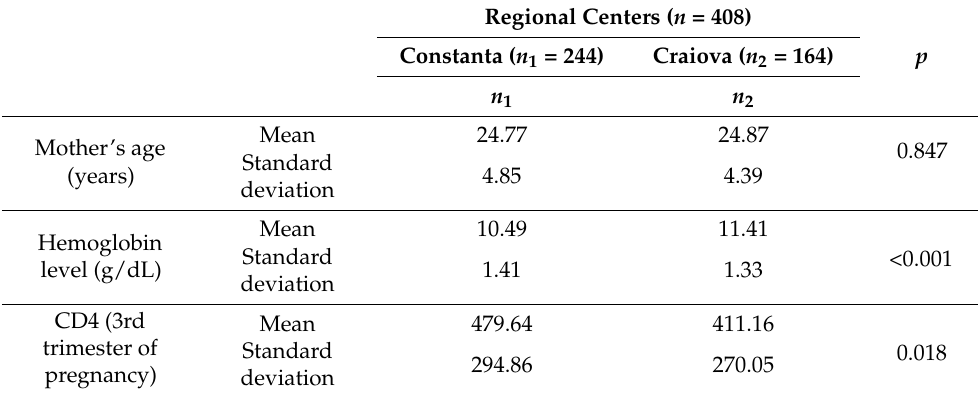
Table 1. HIV-positive pregnant women’s parameters in the last trimester of pregnancy. Regional Centers ( n =